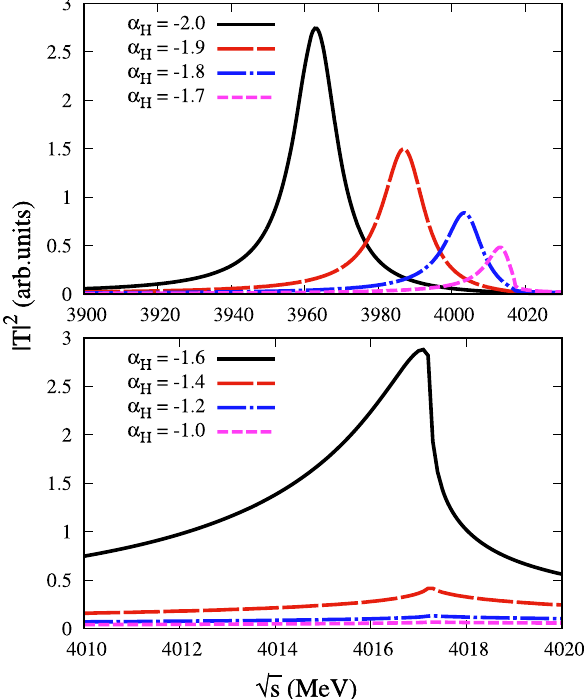
Fig. 3 The mass and width of pole depending on the parameter α H for | 2 for the Fig. 2 The modulus squared of the amplitude | T the cases of I ( J PC ) = 0 ( 0 ++ ) , 0 ( 2 ++ ) , and 1 ( 2 ++ ) respectively. The D ∗ ¯ D ∗ → D ∗ ¯ D ∗ case of I = 0 , J = 0 depending on the parameter α H grey horizontal line indicates the D ∗ ¯ D ∗ threshold and the grey horizon- tal band indicates the mass and width range of X ( 4014 ) measured by Belle collaboration [41]. The red arrow indicates α H = 1 . 65, which is the same as α L Table 2 The parameter ranges determined by reproducing the mea- sured mass and width of X ( 4014 ) for different I ( J PC )